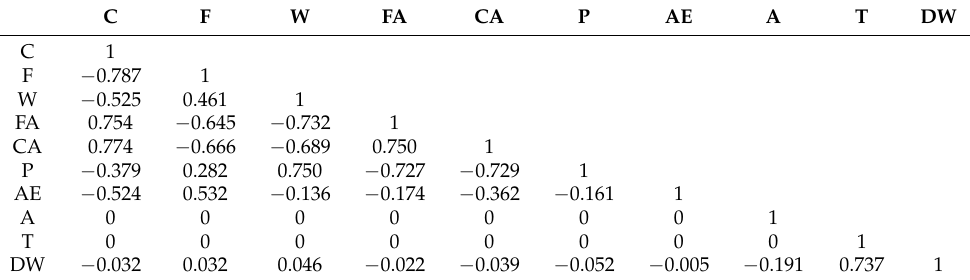
Table 3. Coefficient of correlation for explanatory